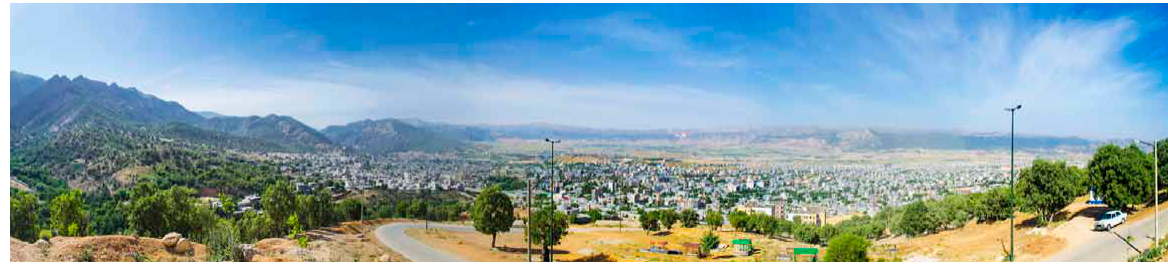
authors)fig. 3. northern view of Yasouj panorama (photo by the authors)